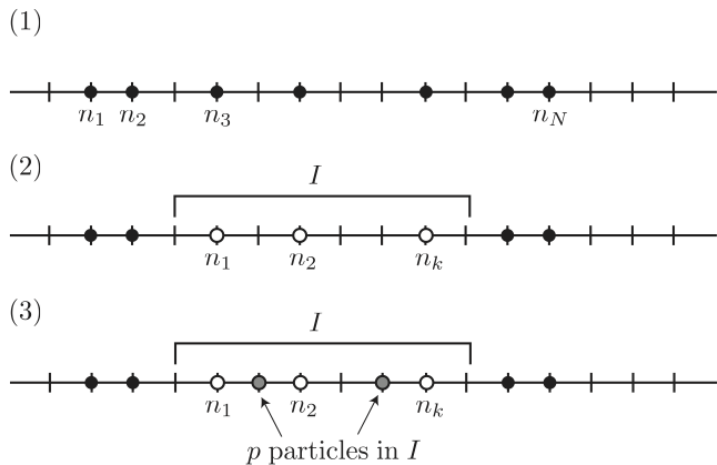
Figure 11 . Distribution of particles. (1) there is a particle at each of the points n i ( i = 1 ; : : : ; N ). (2) there are exactly k particles in I , one in each of k designated points n i ( i = 1 ; : : : ; k ). (3) there are exactly p particles in I except for k designated points n i ( i = 1 ; : : : ; k ). density [73], which is given by the restricted kernel K determinantal point